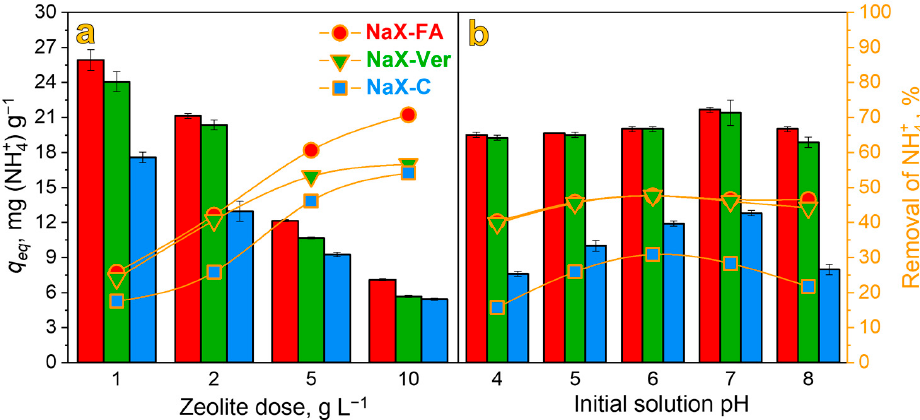
Figure 5. The effect of operating conditions: zeolite dose ( a ) and initial solution pH ( b ) on the adsorption capacity (left Y-axis) and percentage removal (right Y-axis) of ammonium ions. Error bars indicate the standard deviation of duplicate measurements.